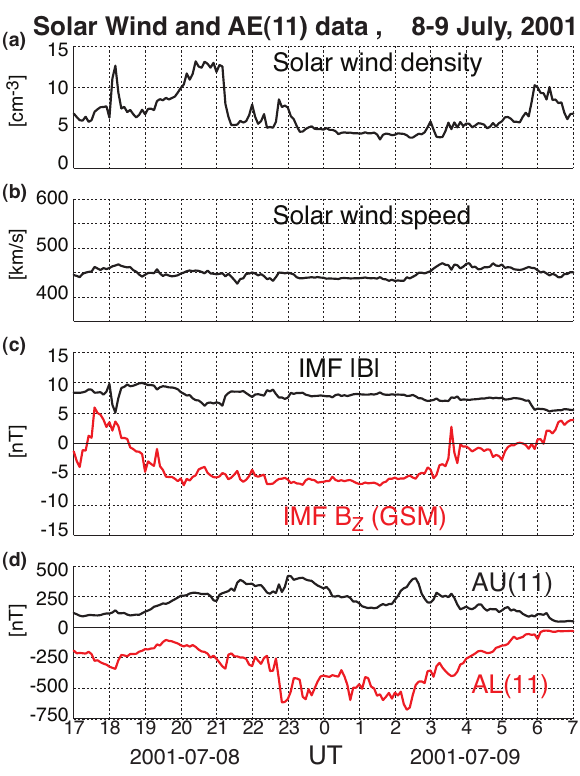
Fig. 2. The solar wind OMNI data and geomagnetic indices from 11 AE stations on 8–9 July, 2001: (a) solar wind density, (b) solar wind velocity, (c) interplanetary magnetic field total strength ( | B | ) and northward component ( B z ), and (d) AU and AL indices from 11 stations. All data are averaged over 5min. Fig. 3. Simulated result for the first event on 9 July 2001. (a) Virtual spectrogram of Cluster spacecraft-4 using the simulated result. The format is the same as Fig. 1 (i.e., except that protons of local pitch angle of 90 ◦ are shown). (b) Elapsed time of ions that is obtained by the backward tracing of the observed data. (c) Equatorial loca- tions of the simulated stripes of 0.1keV protons with 90 ◦ equatorial pitch angle, looking from the north every 30min. The spacecraft location is marked by the blue crosses, and ion drift direction for these 0.1keV protons is illustrated by solid green arrows. The finite length of red dots (0.1keV protons) comes from finite duration of proton injection at the source boundary in the nightside. Figure 3c snapshots the differential flux of protons with energy of 0.1 keV with equatorial pitch angle of 90 ◦ . During the inbound traversal, the 0.1 keV proton stripe did not reach the spacecraft location, while it passed the spacecraft loca- tion at the time of the outbound traversal. Thus, the space- craft can observe significant development of the low-energy population within 1–2